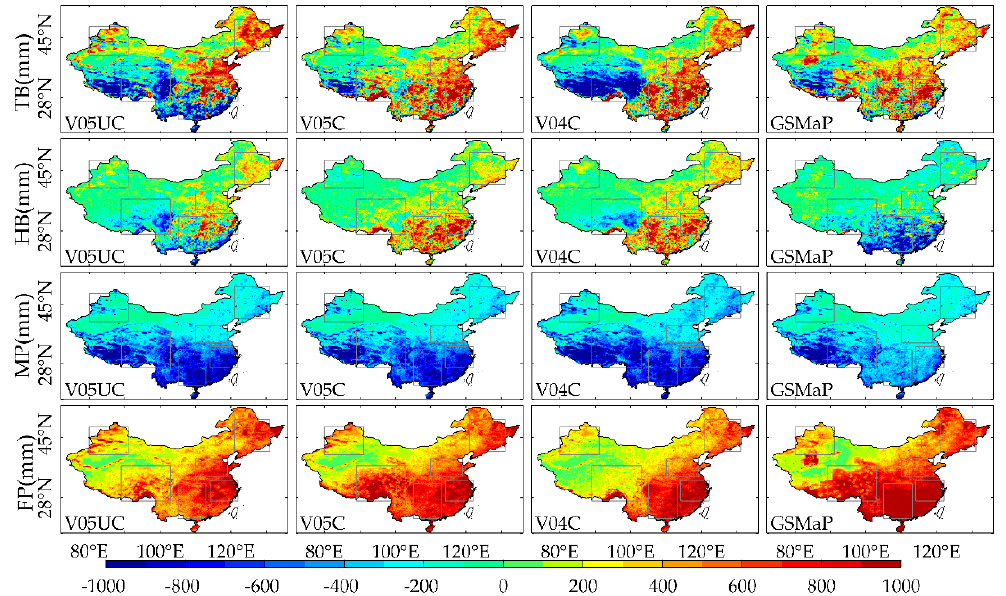
Figure 7. The accumulated error components (mm) of the four GSPEs (i.e., V05UC, U05C, V04C, and GSMaP) for the entire study period from April 2014 to December 2016 at a 3-h and 0.1° × 0.1° resolution.